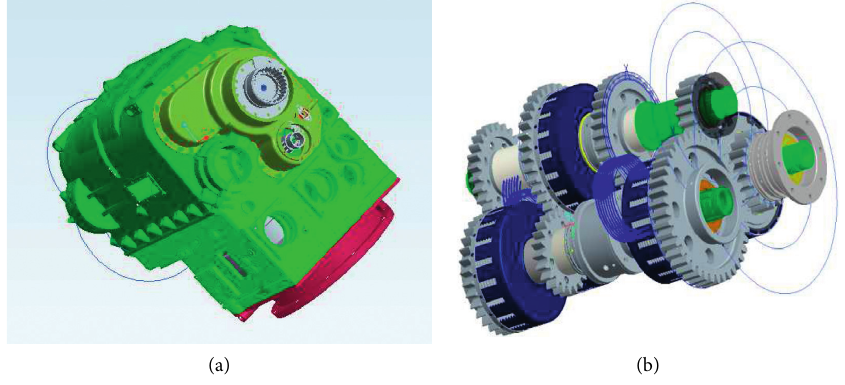
Figure 1: Transmission Model. (a) Transmission housing model. (b) Gear shafting models.